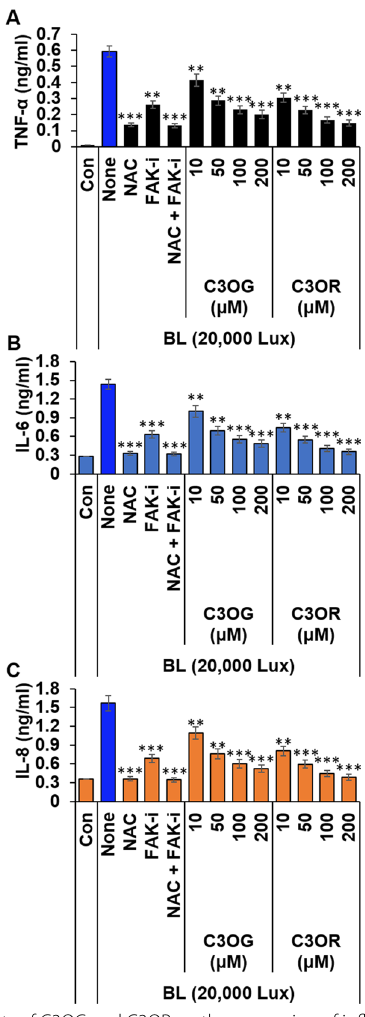
Fig. 4 Effects of C3OG and C3OR on the expression of inflammatory cytokines induced by blue light. HaCaT cells in six‑well plates were exposed to blue light (20,000 lx) for 1 h. Cells were pretreated with or without NAC (10 mM), FAK‑i (1 µM), or NAC FAK‑i for 1 h or different + concentrations (10, 50, 100, or 200 µM) of C3OG or C3OR for 24 h prior to blue light exposure. After 24 h, supernatants were collected, and the amounts of TNF‑α ( A ), IL‑6 ( B ), and IL‑8 ( C ) were determined by ELISA ( n 3, SD). ** p < 0.01 and *** p < 0.001 vs. blue light = ± (20,000 lx)